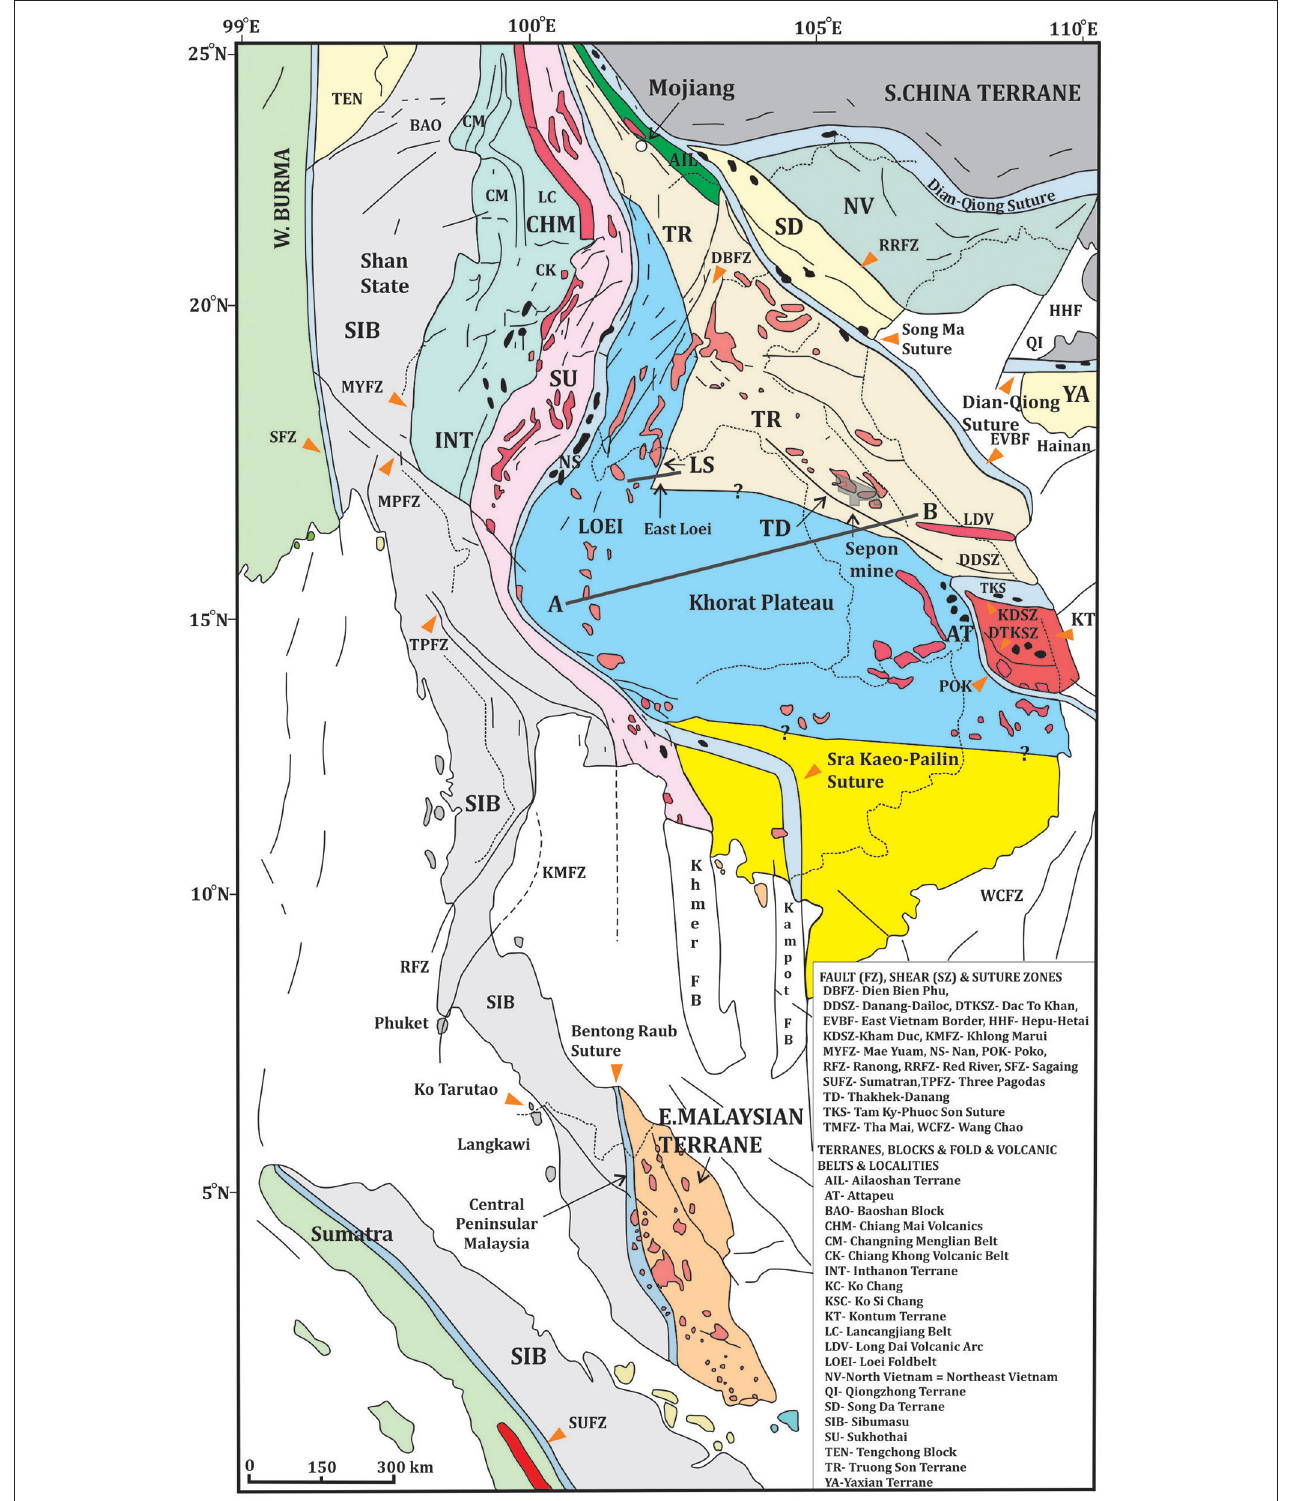
FIGURE 1 | Map of terranes in mainland Southeast Asia. Blue = Loei-Phetchabun Terrane, TR = Truong Son Terrane, Red = KT, Kontum Terrane. Line A-B is line of geological section shown in Figure 3 . TKS, Tamky Suture; LDV, Long Dai Volcanic Arc (latest Ordovician to Silurian). The debatable extension of the Truong Son